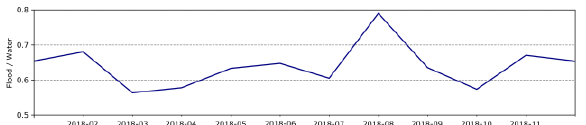
Figure 5. Monthly mean ratio of flood to water pixels over the study area in Kerala in